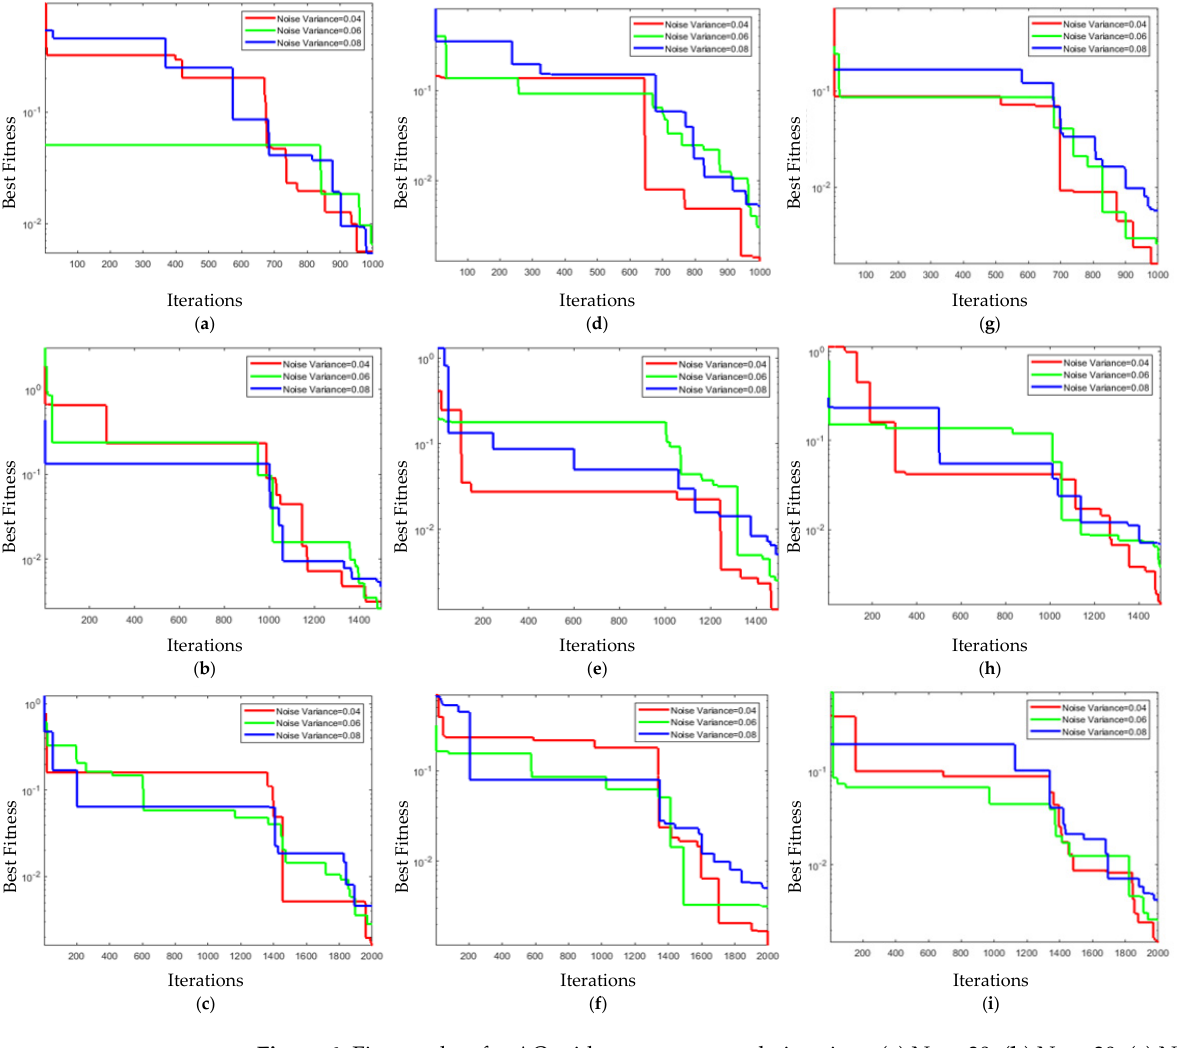
Figure 6. Fitness plots for AO with respect to population sizes. ( a ) Np = 30. ( b ) Np = 30. ( c ) Np = 30. ( d ) Np = 40. ( e ) Np = 40. ( f ) Np = 40. ( g ) Np = 50. ( h ) Np = 50. ( i ) Np = 50. To further investigate the exploration and exploitation phase of the AO, it is com- pared with the arithmetic optimization algorithm (AOA) [44], the sine cosine algorithm (SCA) [45], and the reptile search algorithm (RSA) [46] for 15 independent runs with 3 variations of generation (1000, 1500, 2000) and population (30, 40, 50). Tables 15–17 shows the performance of all algorithms in terms of estimated weights and best fit for 0.04, 0.06, and 0.08 noise levels. It is seen that the algorithm gives better results at low noise, i.e., 0.04, than at high noise. Moreover, for low noise, the estimated weights are closer to the true values with minimum fit. Table 15. Comparison of AO with AOA, SCA, and RSA against the true values for the CAR model at 0.04 noise variance.